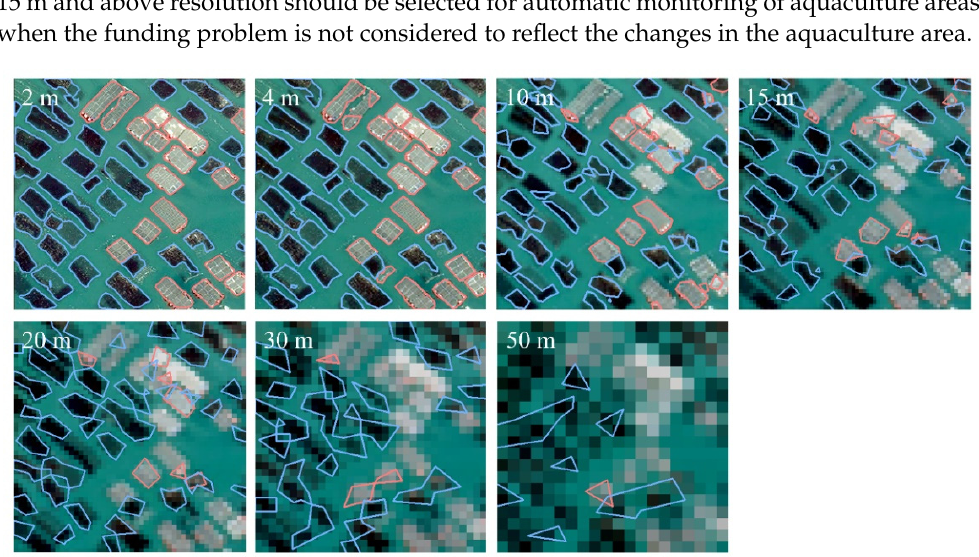
Figure 5. Aquaculture areas with seven different spatial resolutions under the same location and the identification effect, where the blue box represents raft culture area and the red box represents cage culture area.